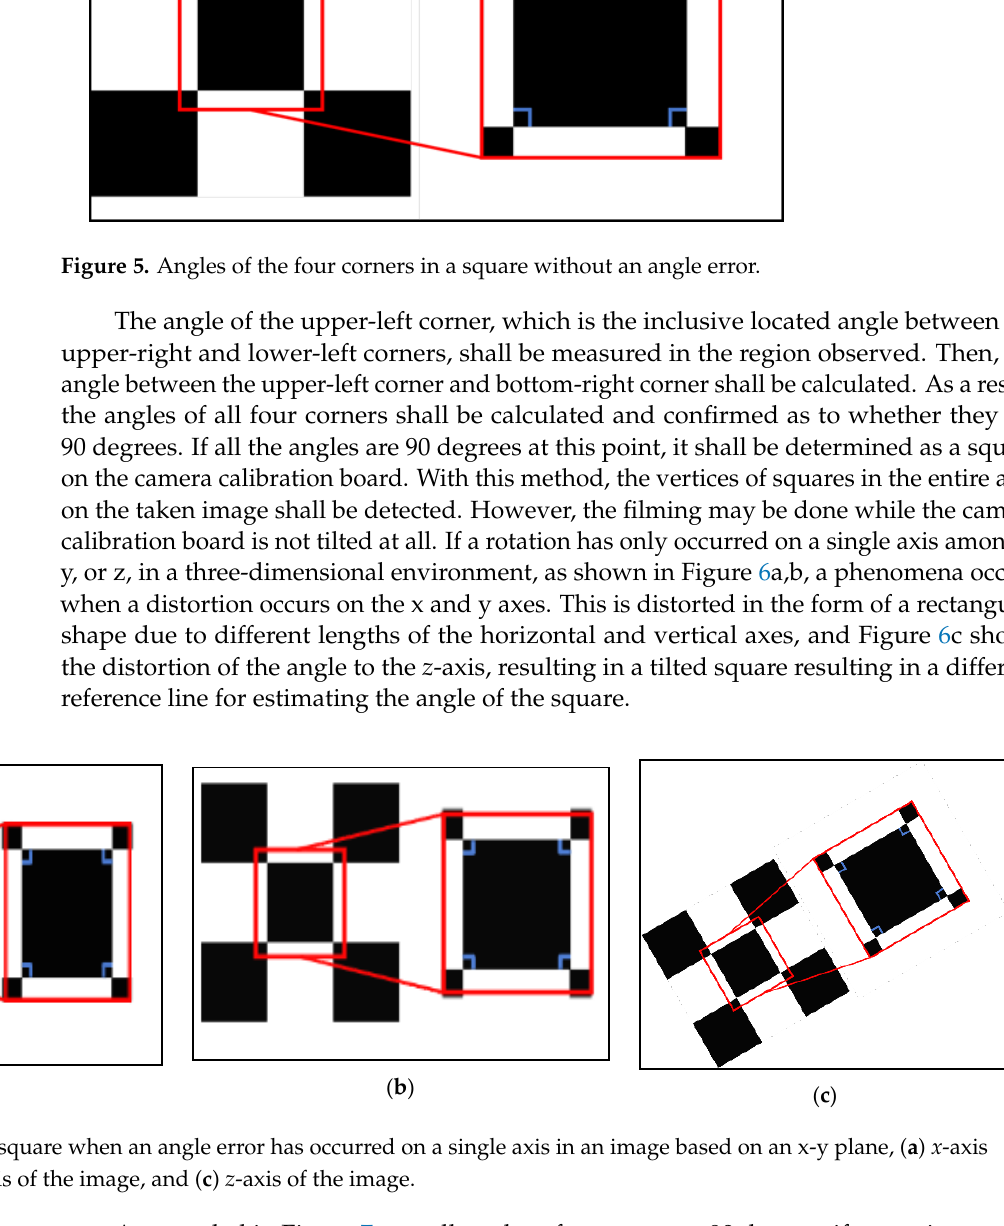
adjacent outermost